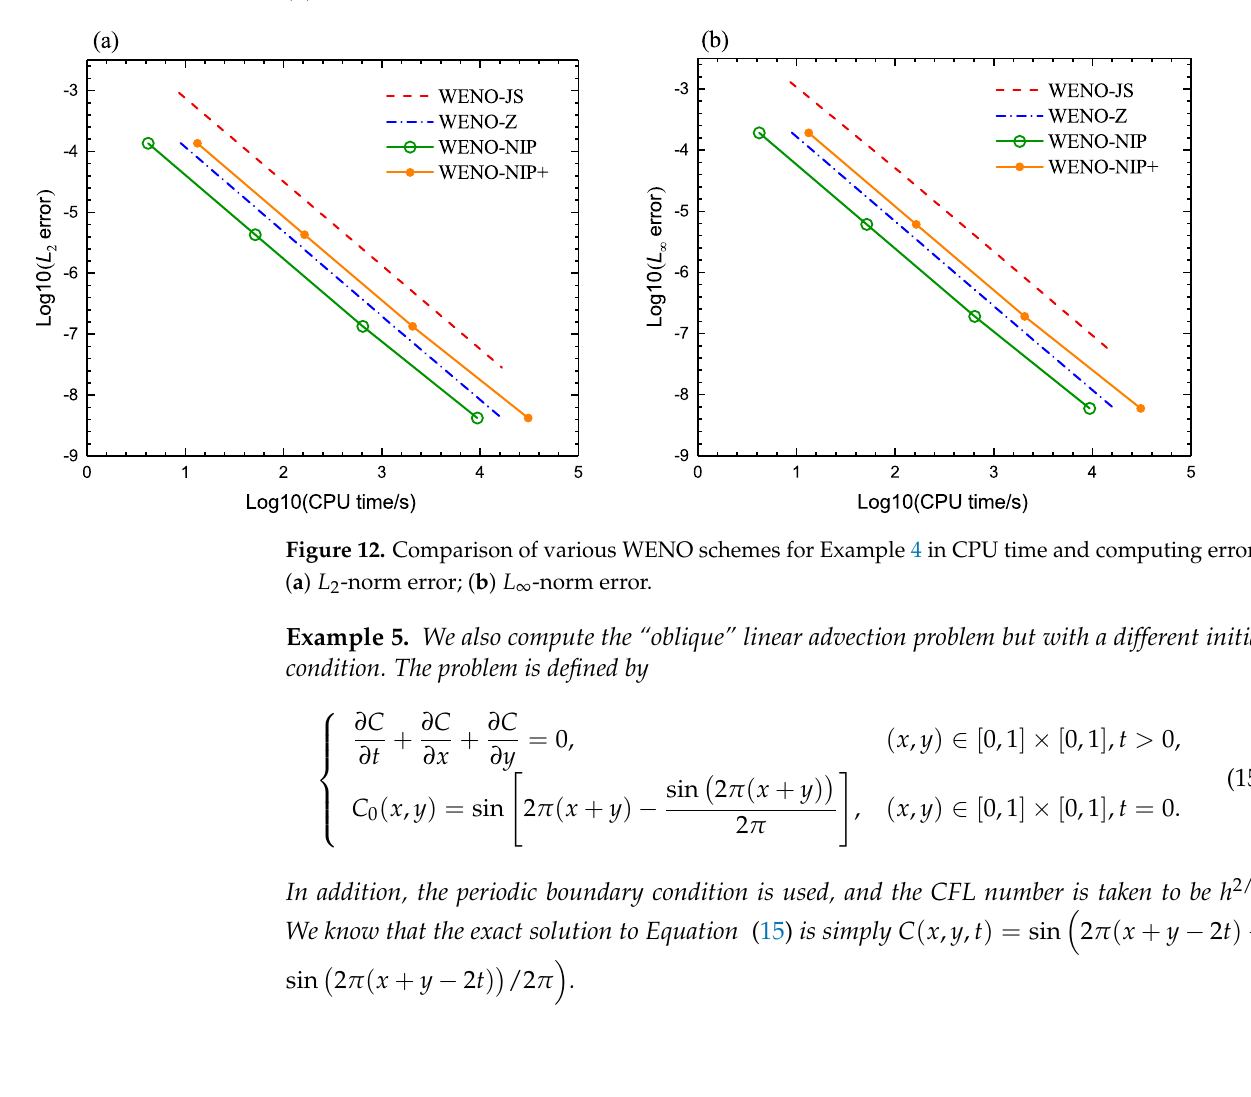
Figure 11. Plots of computing errors for different WENO schemes for Example 4: ( a ) L 2 -norm error; ( b ) L ∞ -norm error.